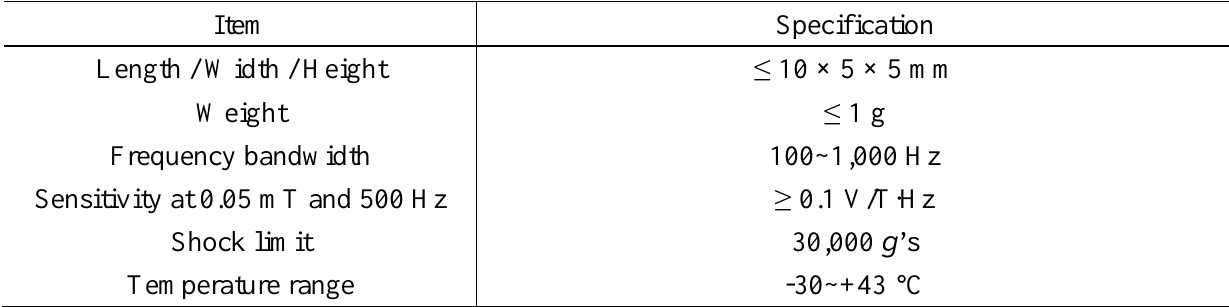
Table 1. Design requirements of MMIS using geomagnetism for turn count of small-caliber